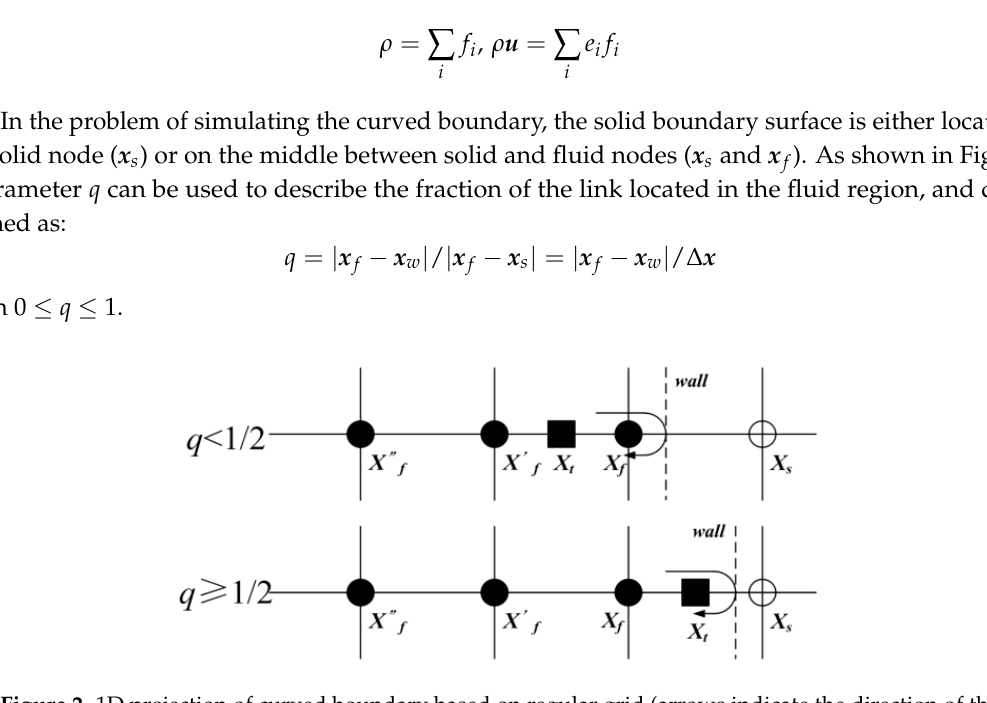
Figure 2. 1D projection of curved boundary based on regular grid (arrows indicate the direction of the fluid particle movement).